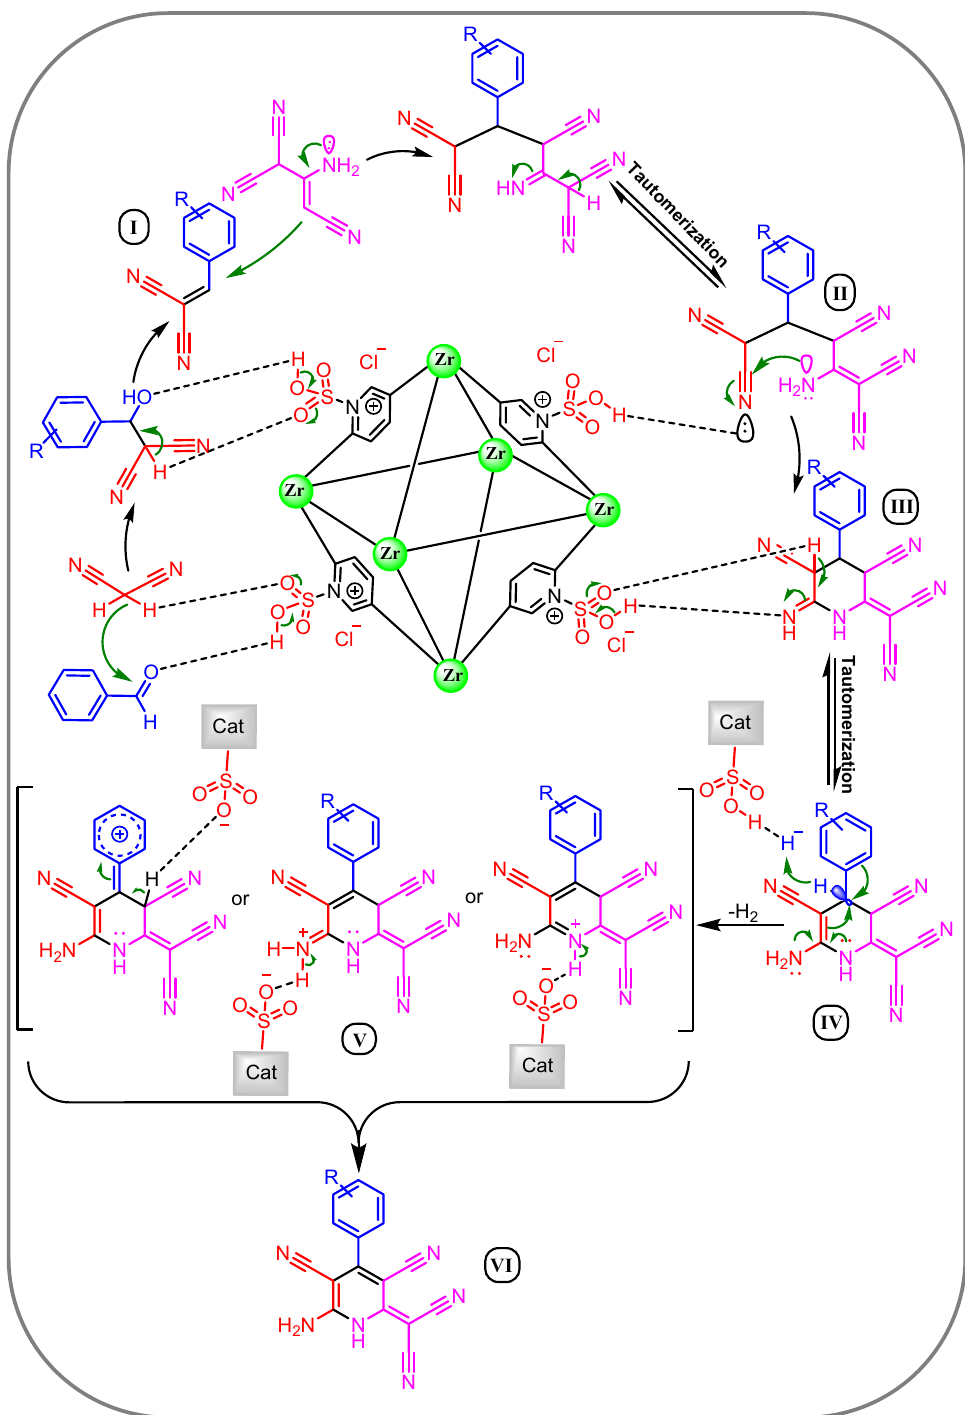
Figure 9. A rational proposed mechanism for the synthesis of dicyanomethylene pyridine using [Zr-UiO-66- PDC-SO 3